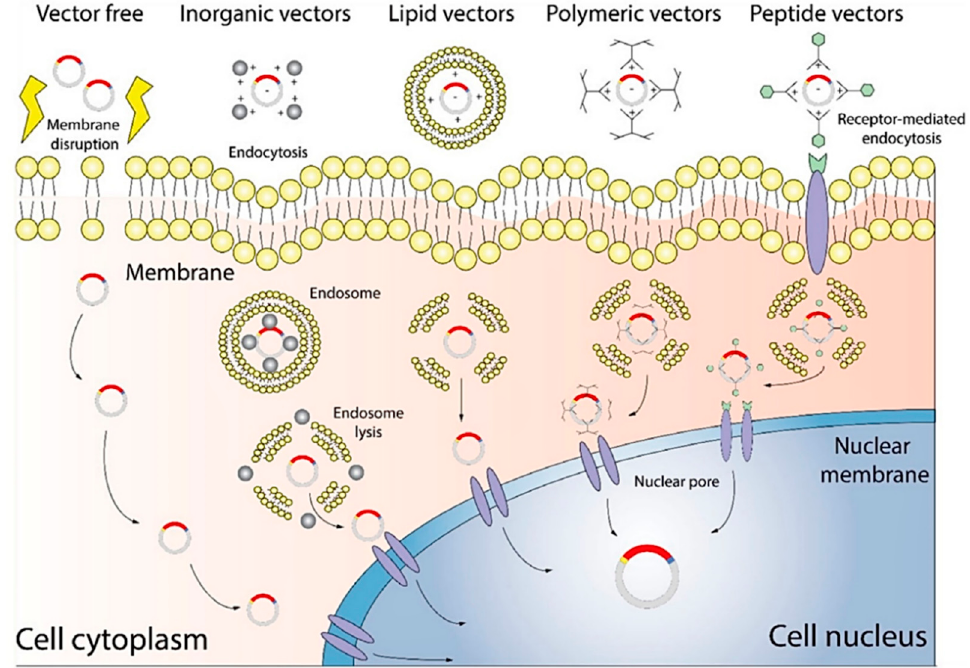
Figure 2. Diagram of a non-viral gene delivery system. Vector-free technology delivers target genes by altering the cellular membrane, while other vectors deliver target genes through interactions with the membrane, for example, endocytosis [39]. Copyright: Wiley Online Library.